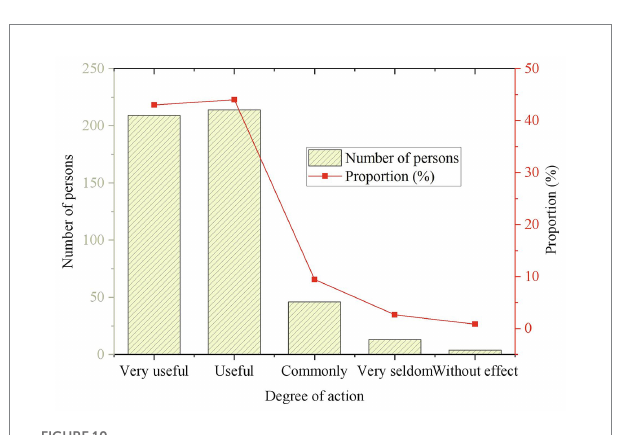
FIGURE 10 Can the participation of folk art play a role in regulating emotions or releasing stress?